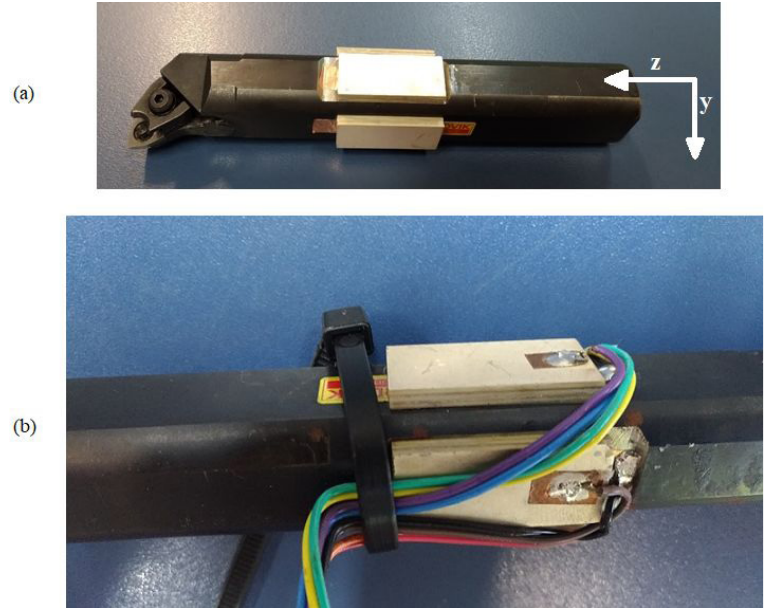
Figure 5. Assembly of multilayer piezoelectric actuators a) modified tool-holder; b) finished tool-holder with